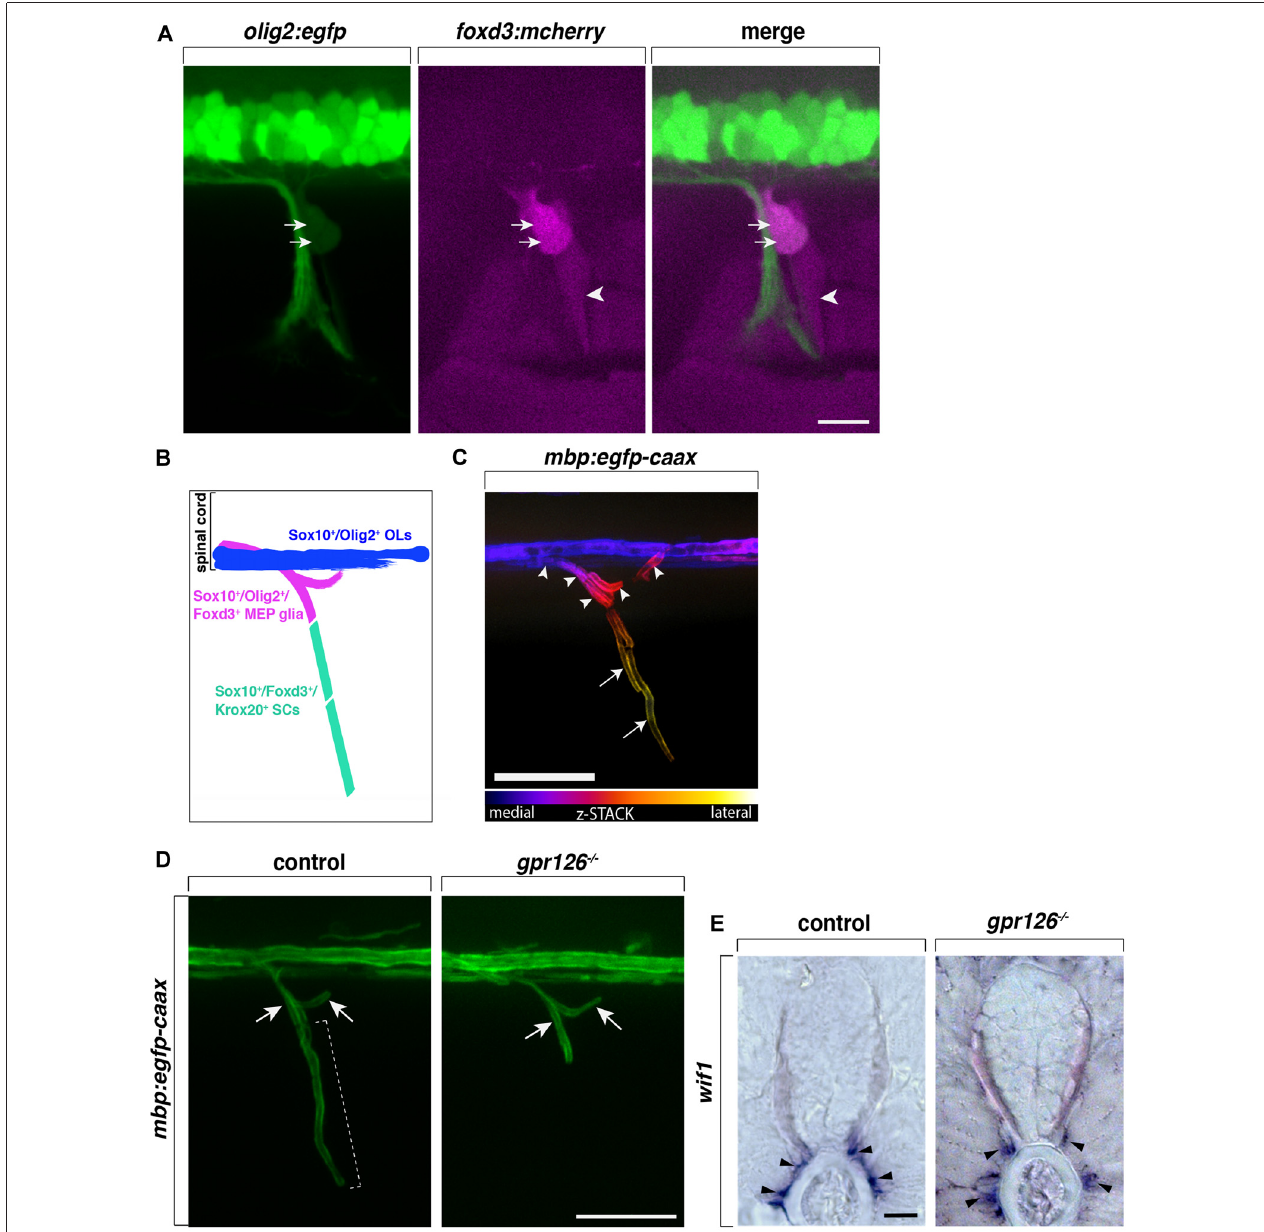
FIGURE 1 | Centrally-derived motor exit point (MEP) glia myelinate motor nerve roots. (A) Lateral view of a olig2:egfp;foxd3:mcherry zebrafish trunk showing olig2 + /foxd3 + MEP glia (arrows) and olig2 − /foxd3 + SCs (arrowheads) along a motor nerve at 55 hour post-fertilization (hpf). (B) Diagram representing central and peripheral myelinating glial markers. (C) Pseudo-colored z-stack of a lateral view of a mbp : egfp-caax trunk at 5 day post-fertilization (dpf). MEP glial myelin sheaths (arrowheads) originate within the spinal cord and project laterally along motor nerve axons, coming close to schwann cells (SC) myelin (arrows). (D) SC myelin (bracket) but not MEP glial myelin (arrows) is absent in G-protein coupled receptor 126 ( gpr126 ) mutants at 5 days post fertilization (dpf). (E) In situ hybridization showing the presence of Wnt-inhibitory factor 1 ( wif1 + ) MEP glia (arrowheads) along motor nerve roots in 3 dpf control and gpr126 mutant larvae. Scale bar, (A–D) 50 µ m, (E) 20 µ